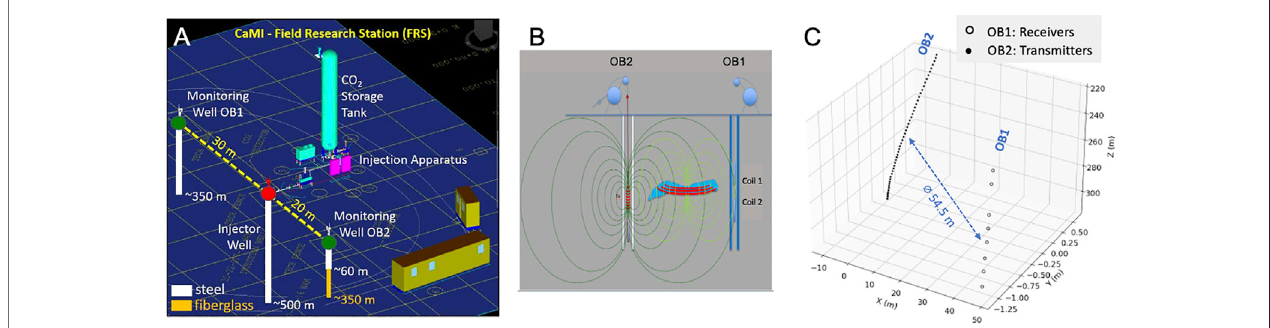
FIGURE1 |(A) : Schematic view ofCaMI.FRS site with injector and monitoring wells. (B) :Schematic ofacrosswell EMcon fi guration. Primary EM fi elds are emitted in the transmitter well and recorded together with induced secondary vertical magnetic fi elds in an adjacent receiver well. Data processing steps separate the signals so that the rock electrical resistivity information is derived from the secondary fi elds. (C) : Actual positions of the magnetic transmitter and receiver coils. The two wells OB1 and OB2 are deviated, with an average of 54.5 m separating the instrumented